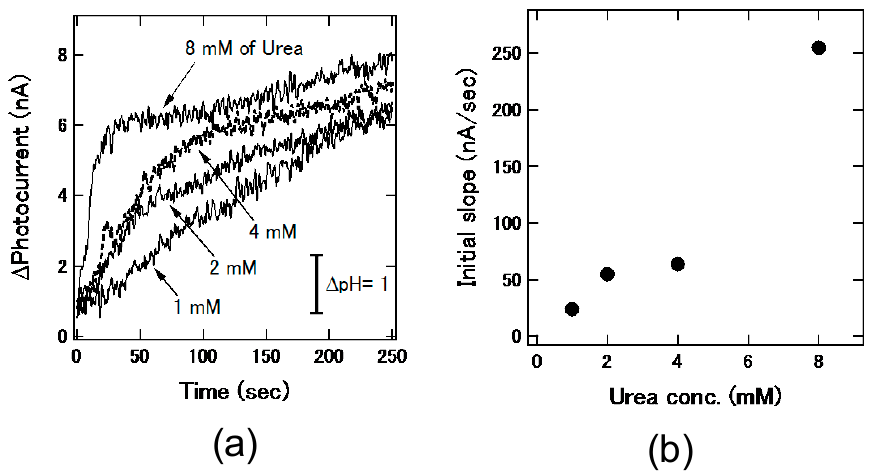
Figure 7. ( a ) Temporal change of photocurrent after merging a plug of urea solution and that of urease solution. The photocurrent response varied depending on concentrations of urea; ( b ) Initial slope of photocurrent change as a function of the urea concentration.